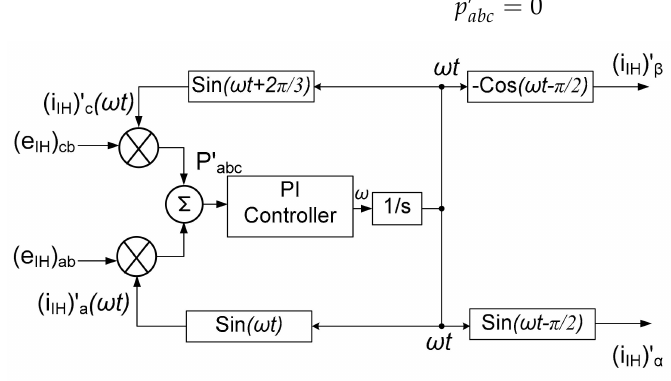
Figure 4. Block diagram of a PLL circuit.